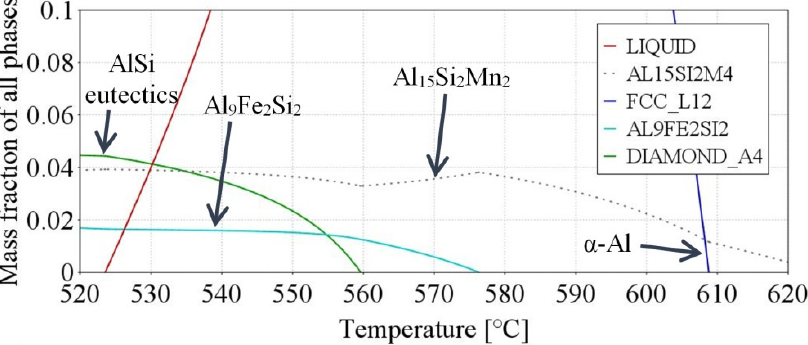
Figure 13. Property diagram for the AlCu4Si6Fe1.0Mn0.65 alloy.